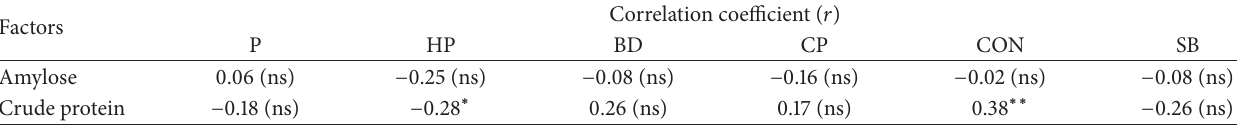
Table 4: Correlation coefficient ( 𝑟 ) among various physicochemical characteristics of rice